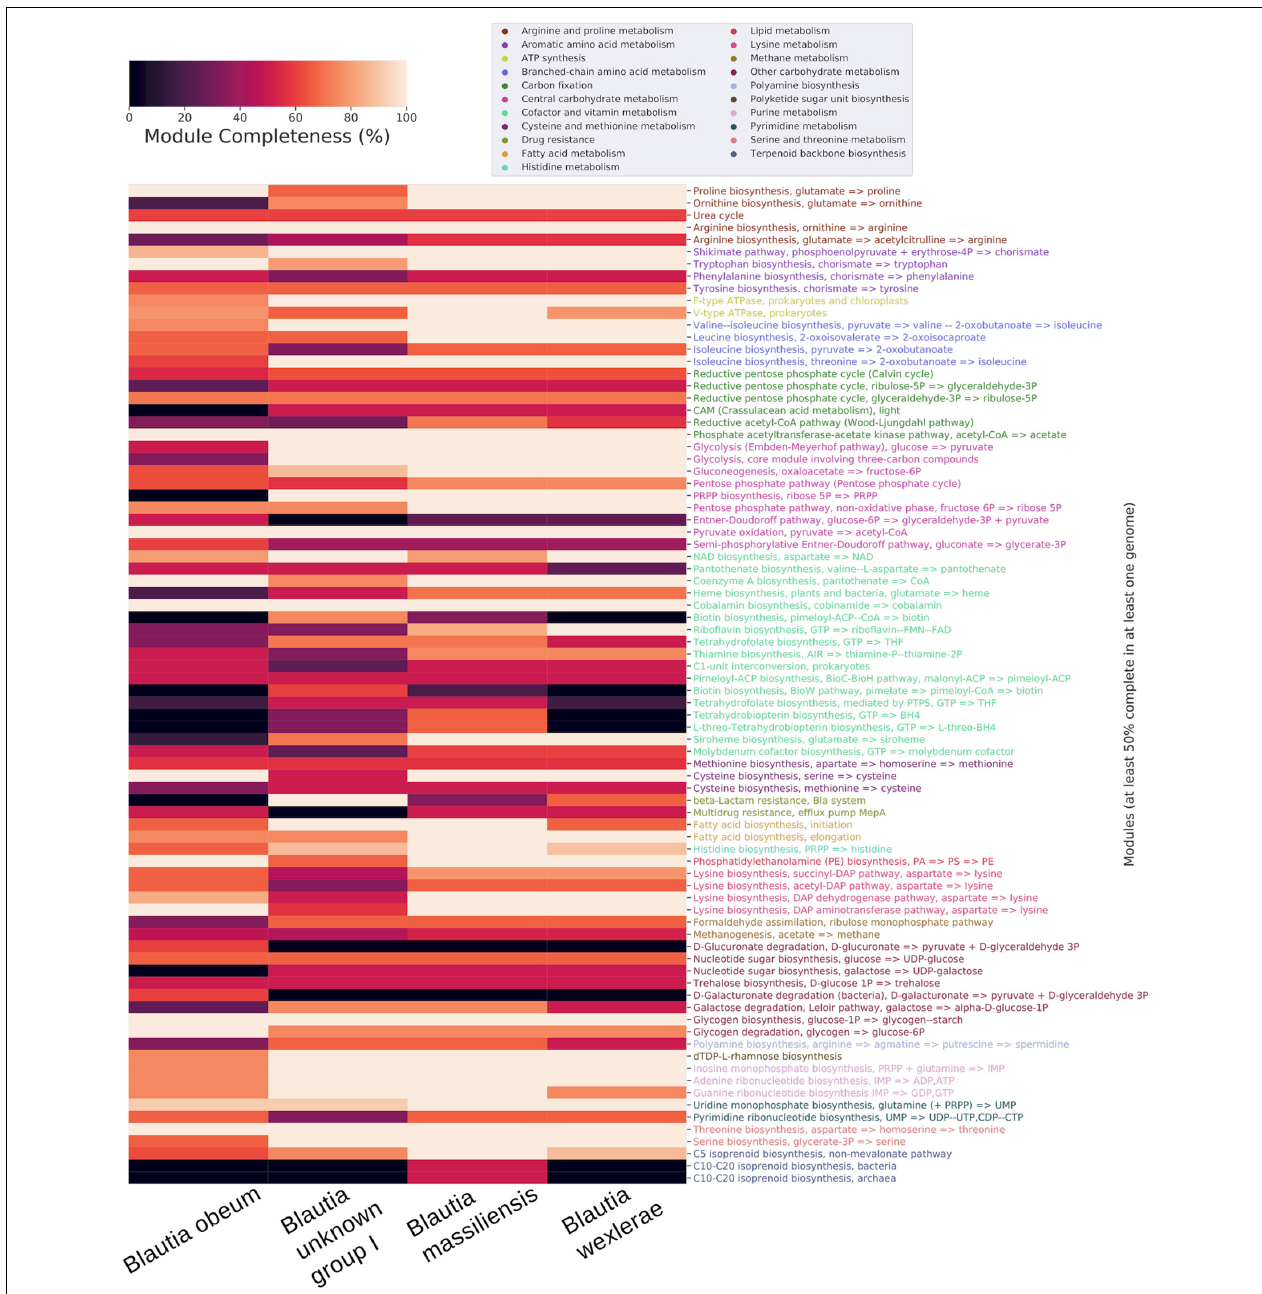
FIGURE 3 | Heatmap of the KEGG modules completeness of the core pangenomes of 4 selected genomic species groups, clustered by category of metabolism. All clades have at least 23 genomes and are composed of genomes pertaining exclusively to one cluster defined by ANI. Only modules with 50% completeness or more were